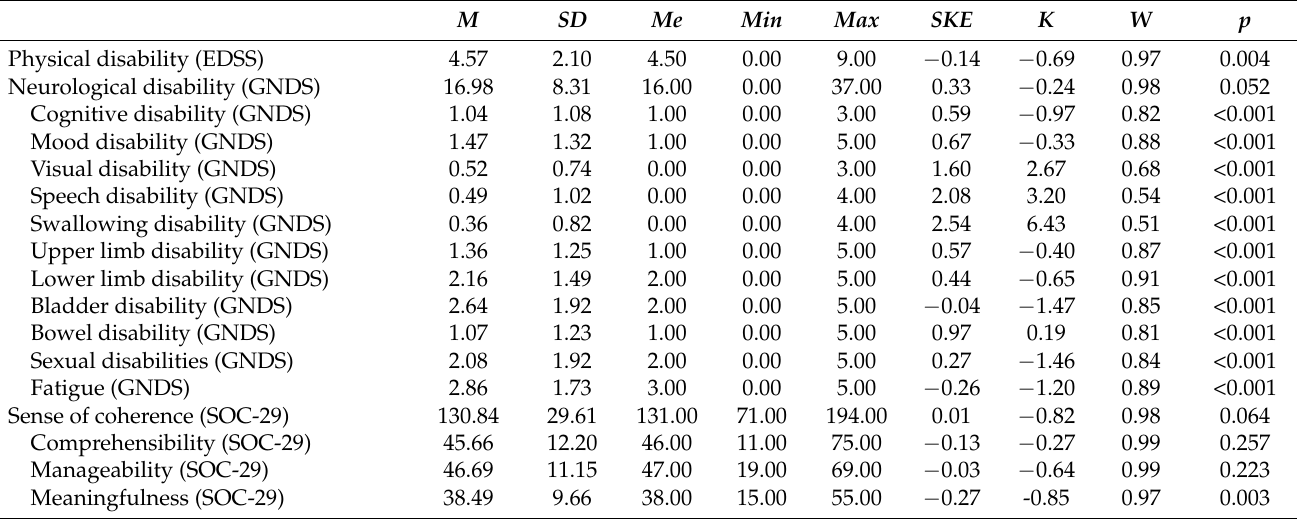
Table 2. Descriptive statistics for the tested